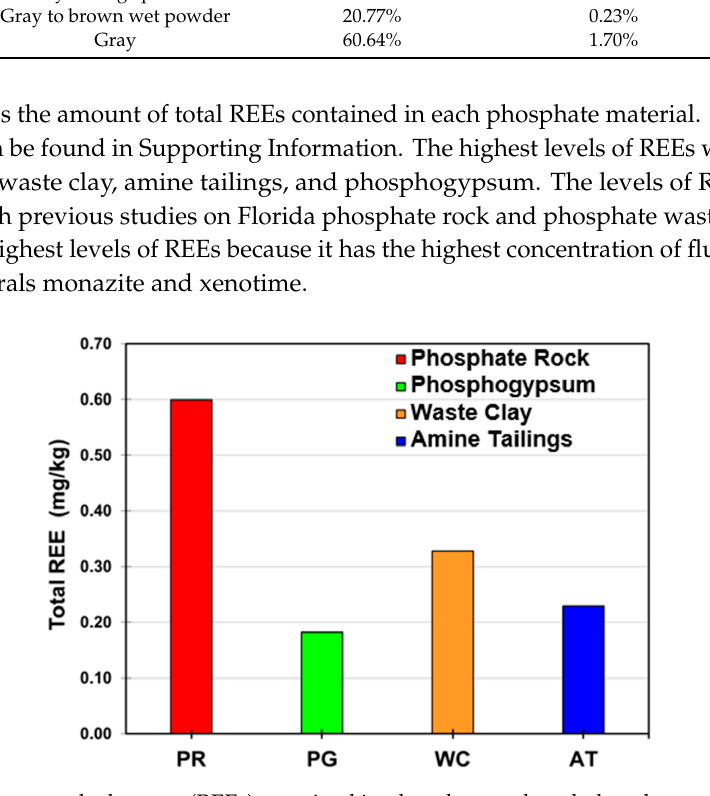
Figure 1. Total rare earth elements (REEs) contained in phosphate rock and phosphate waste materials